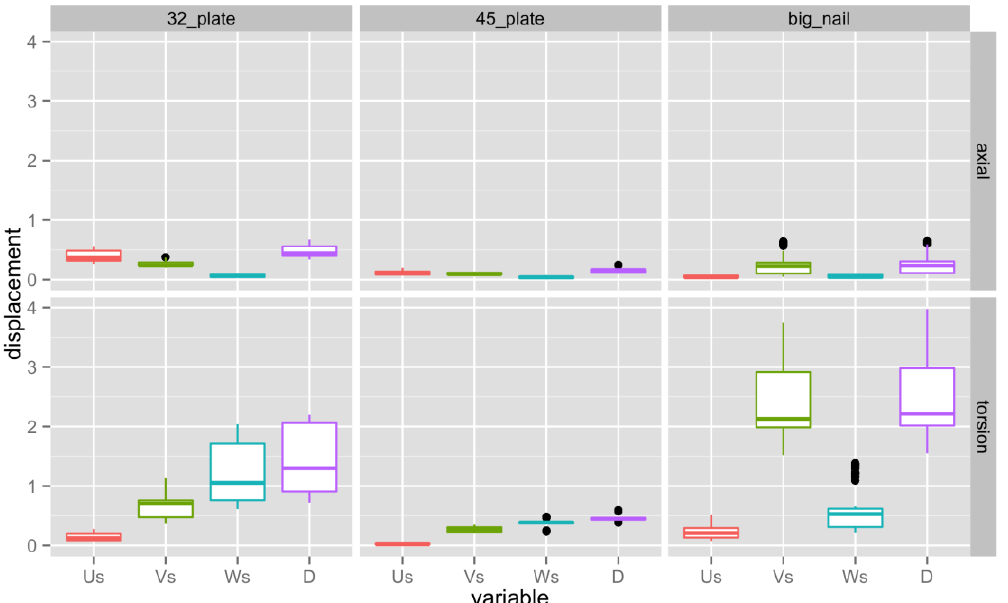
Figure 2. Us is fracture motion in the proximal/distal direction, Vs is in the medial/lateral direction, and Ws is in the anterior/posterior direction. The total interfragmentary motion D is the vector sum of the motions in the different directions. The 3.2 plate stands for the small additional plate, the 4.5 plate stands for the larger additional plate, and the big nail stands for the exchange nail. The different colors have been added to allow for a clearer determination of the information. In every column the middle horizontal line is the median. The box goes from the 25 th percentile to the 75 th percentile and the black dots mark the extreme values.